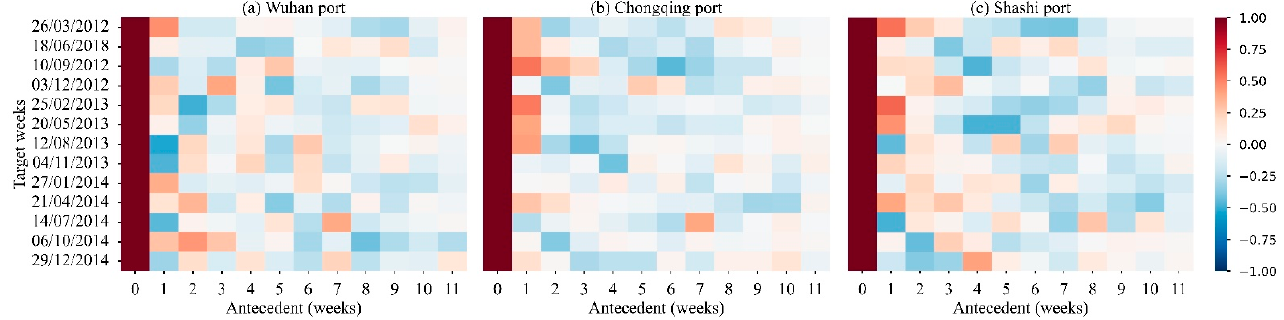
Figure 6. The weekly autocorrelation of freight volume data in Wuhan port, Chongqing port, and Shashi port.